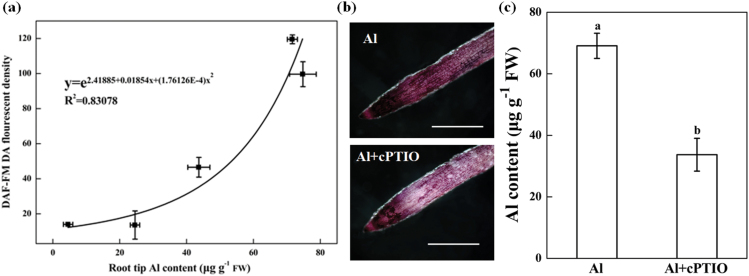
Relationship (P < 0.05) between Al accumulation and NO production. Three-day-old wheat seedlings were treated with 30 μM Al and with or without 30 μM cPTIO and 10-mm root tips were collected after 3, 6, 12, and 24h. (a) Correlation analysis of Al concentrations and NO production after 3, 6, 12, and 24h Al exposure. (b) Histochemical detection of Al accumulation by hematoxylin staining in the root apices after 24h of Al treatment. Scale bar, 0.5cm. (c) Al concentrations in root apices after 24h Al exposure.